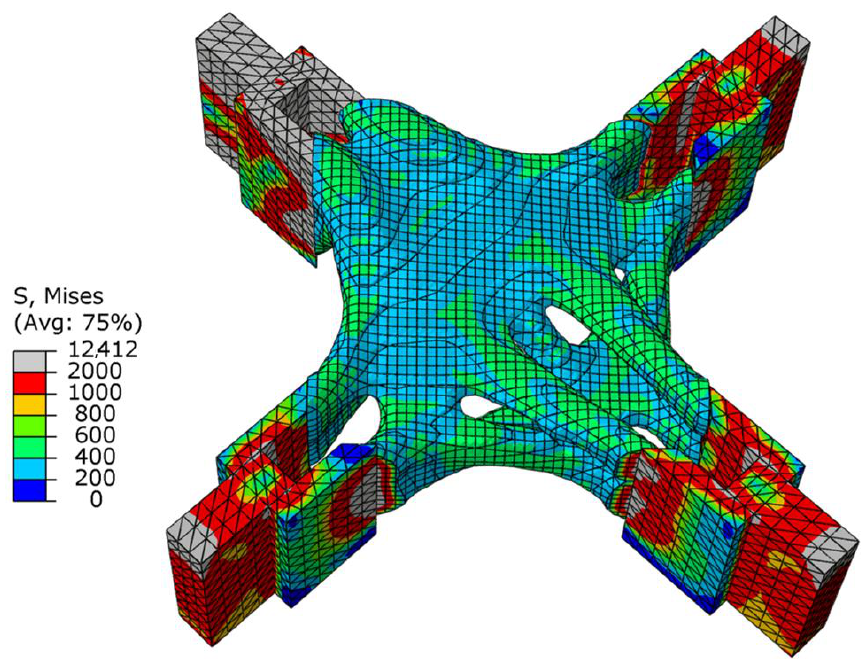
Figure 17. Stress cloud diagram of SIMP optimization results under shear conditions. Table 3. Comparison of optimization results of combined working conditions.